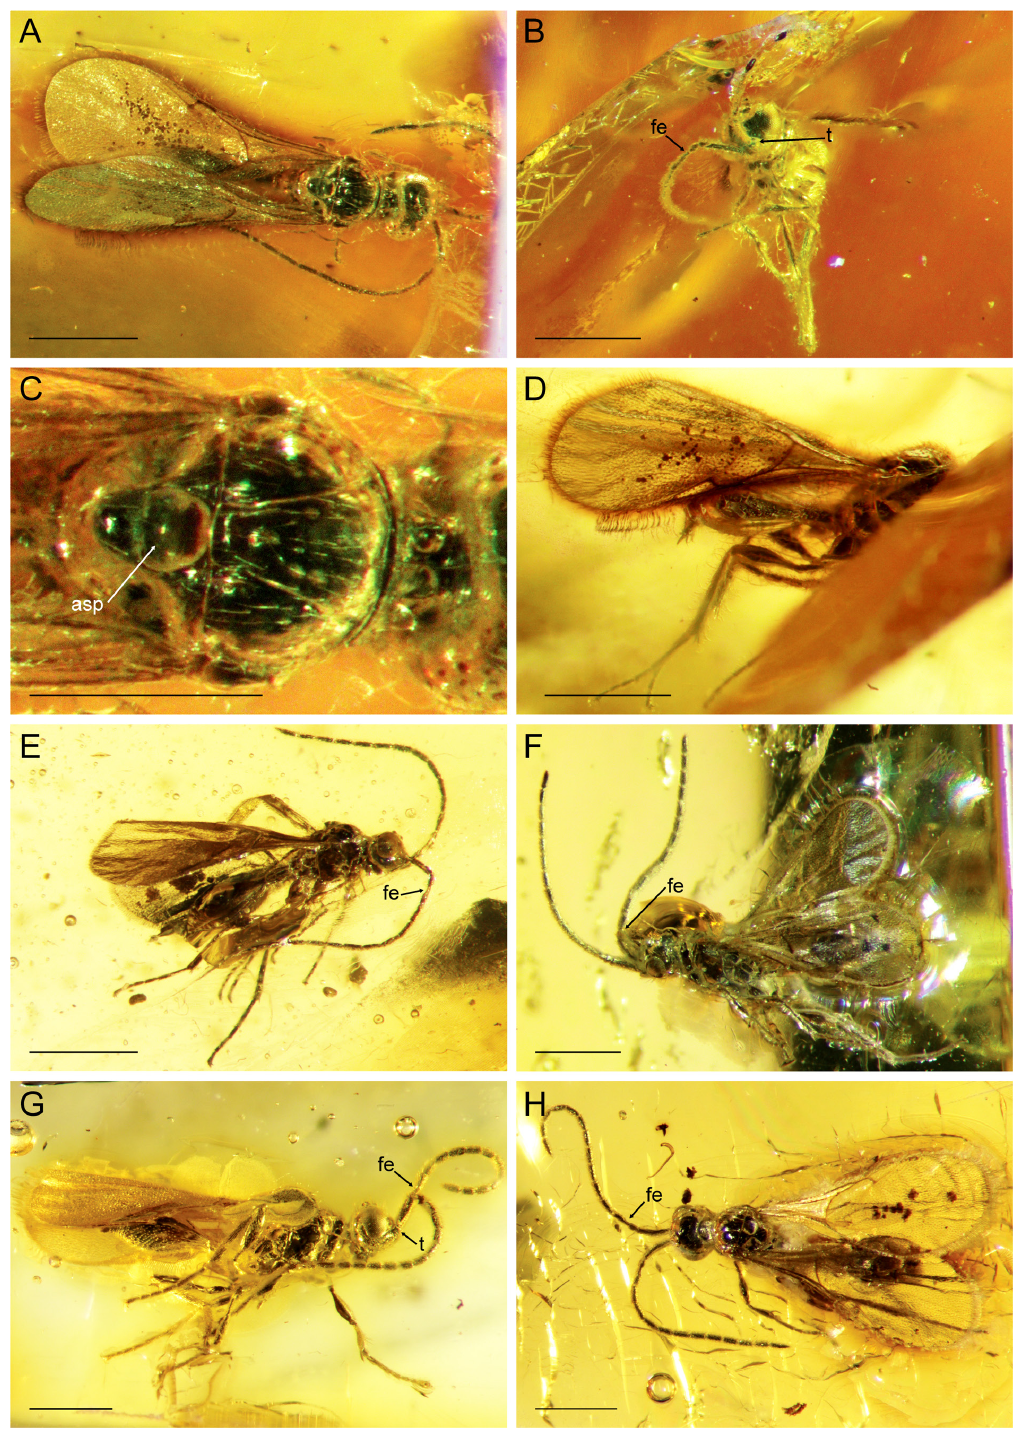
Fig. 4. Pantolyta augustinusii sp. nov. A–D . Holotype (NHMD-300829). A . Habitus in dorsal view. B . Head in frontal view. C . Detail of the anterior mesosoma in dorsal view. D . Gaster and petiole in lateral view. E . Paratype (NHMD-608391), habitus in lateral view. F . Paratype (NHMD-608406), habitus in lateral view. G . Paratype (NHMD-608412), habitus in lateral view. H . Paratype (NHMD-608404), habitus in dorsal view. Abbreviations: asp = anterior scutellar pit; fe = flagellomere emargination; t = toruli. Scale bars: A–B, D–H = 1 mm; C = 0.5